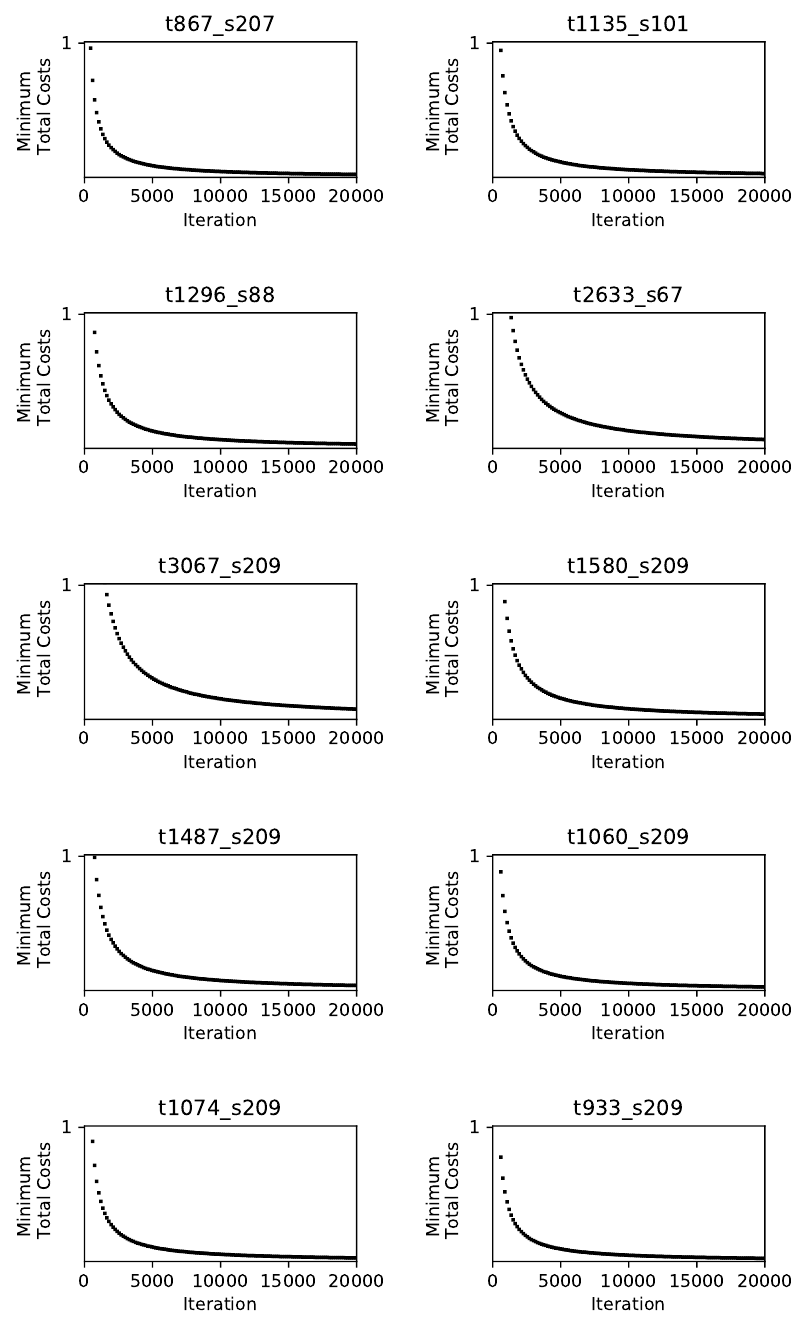
Figure 4. Overview of convergence behaviour for all problem instances solved by Algorithm